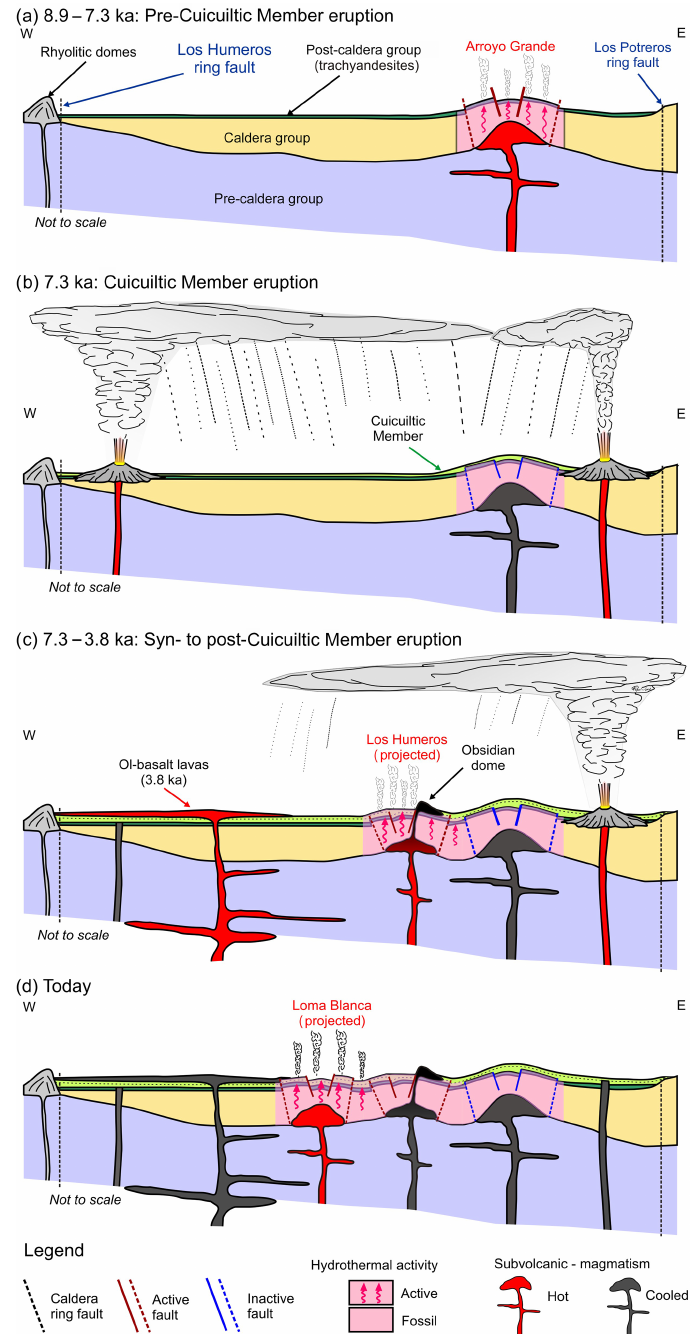
Figure 10. Schematic model of the evolution of the subsurface structure of the Los Potreros caldera floor. Multiple magmatic intrusions located at relatively shallow depth ( < 1km) are responsible for the localized bulging of the caldera floor (Loma Blanca, Los Humeros and Arroyo Grande uplifted areas). (a) Pre-Cuicuiltic Member eruption: emplacement of a felsic intrusion at shallow depth and formation of the Arroyo Grande bulge characterized by extensional faulting at its top, reverse faulting at its base and hydrothermal activity. (b) Cuicuiltic Member eruption: eruption of the Cuicuiltic Member covering the hydrothermally altered post-caldera trachyandesitic lavas. (c) Syn- to post-Cuicuiltic Member eruption: formation of the Los Humeros Fault and extrusion of obsidian lava domes along the fault scarp. As the trachyandesitic domes are covered with Cuicuiltic Member only at the base, the lava extrusion occurred during and after the Cuicuiltic Member eruption. (d) Formation of the Loma Blanca bulge with the current hydrothermal activity and extensional faulting occurring within the apical depression. Notice that the emplacement of the successive most recent domes (Los Humeros and Loma Blanca) are not aligned on the same plane; they are shown for practical